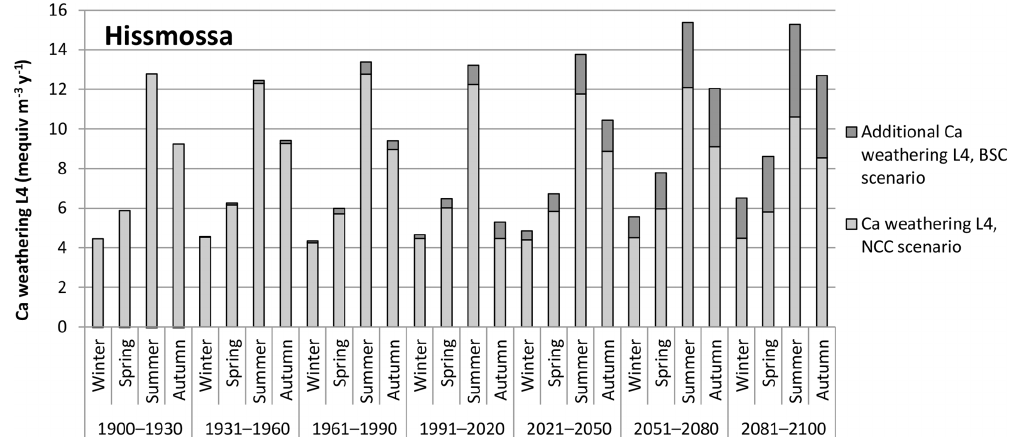
Figure 6. The effect of the increased temperature of the BSC scenario on Ca weathering in L4 at Hissmossa, compared to the NCC scenario with no climate change, shown as averages for seasons over periods of 30 years. Winter – December, January and February; spring – March, April and May; summer – June, July and August; and autumn – September, October and November.